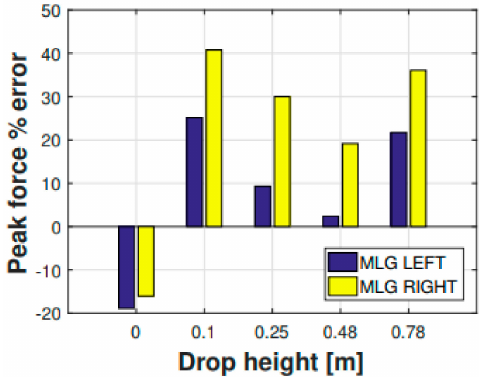
Figure 8. Main landing gear (MLG) shock absorbers total force for the 0.48 m drop: ( a ) right side; ( b ) left side.